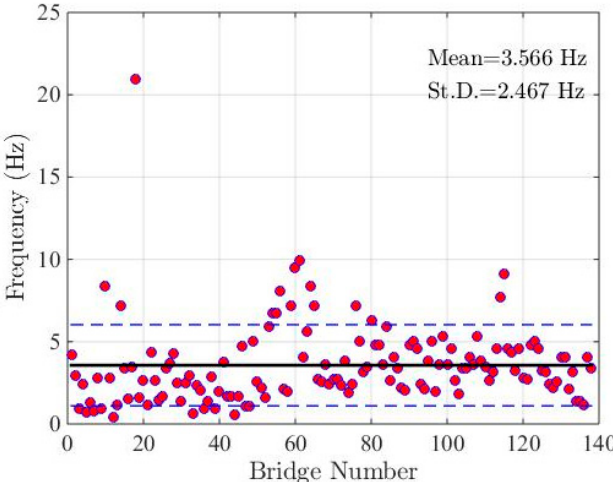
Figure 4. Natural frequencies of the first bending mode for the analytical structures.